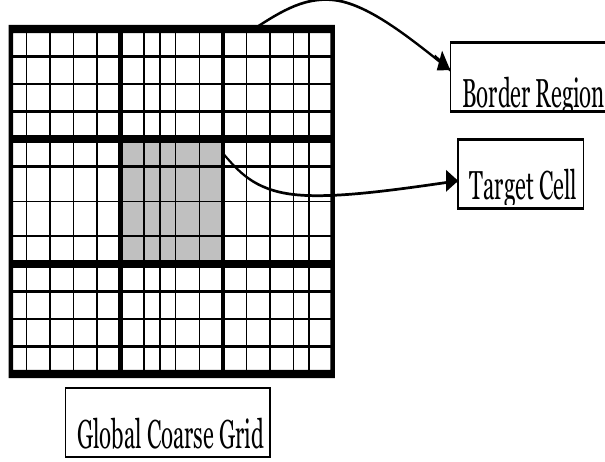
Figure 5. Extended local method for upscaling